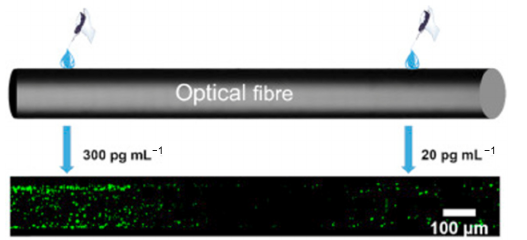
Figure 16. Localized determination of IL-6 by dropping two different concentrations of IL-6 on the fiber surface. Reprinted with permission from [220].